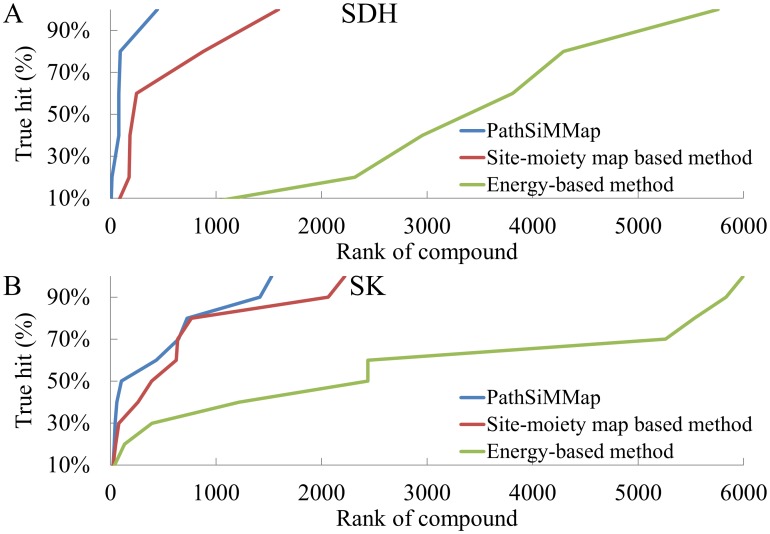
Performance of the PathSiMMap compared with site-moiety map-based and energy-based methods for (A) SDH and (B) SK.The PathSiMMap (blue line) is the best and significantly outperforms the site-moiety map (red line) and the energy-based method (green line) for identifying SDH and SK inhibitors.